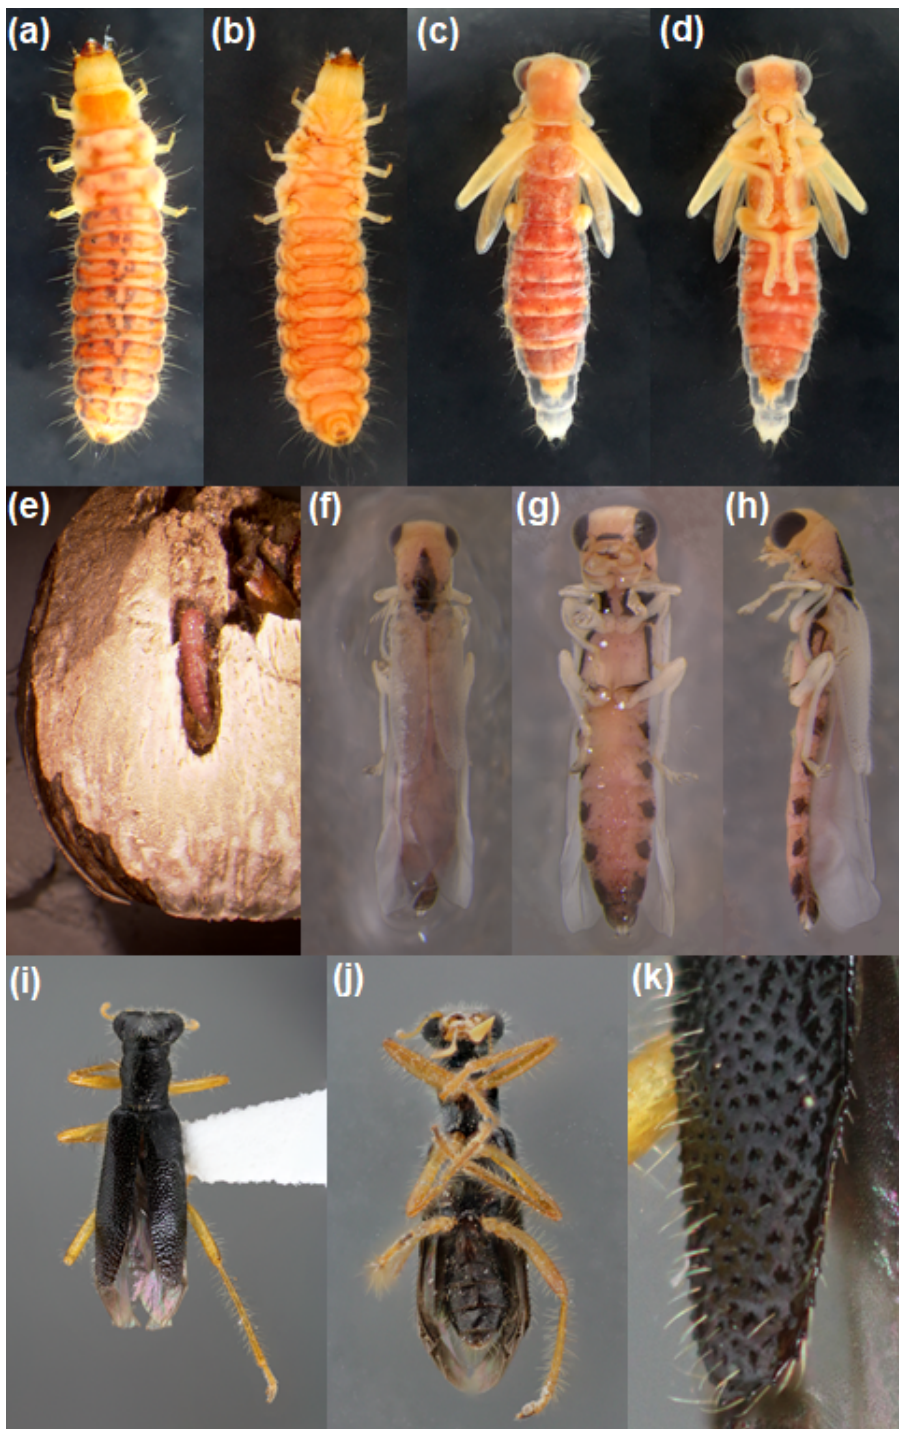
Figure 2. Isohydnocera tabida : ( a ) larva dorsal view, ( b ) larva ventral view, ( c ) pupa dorsal view, ( d ) pupa ventral view, ( e ) pupa within U. cardui puparial case in chamber of lignified gall on Canada thistle ( f ) teneral adult dorsal view, ( g ) teneral adult ventral view, ( h ) teneral adult lateral view, ( i ) adult dorsal view, ( j ) adult ventral view, ( k ), close-up of the tip of an elytron. Images ( a – d , i – k ) taken by G. Fauske, images ( e – h ) taken by S. J. Swenson and cropped by D. A. Prischmann-Voldseth.